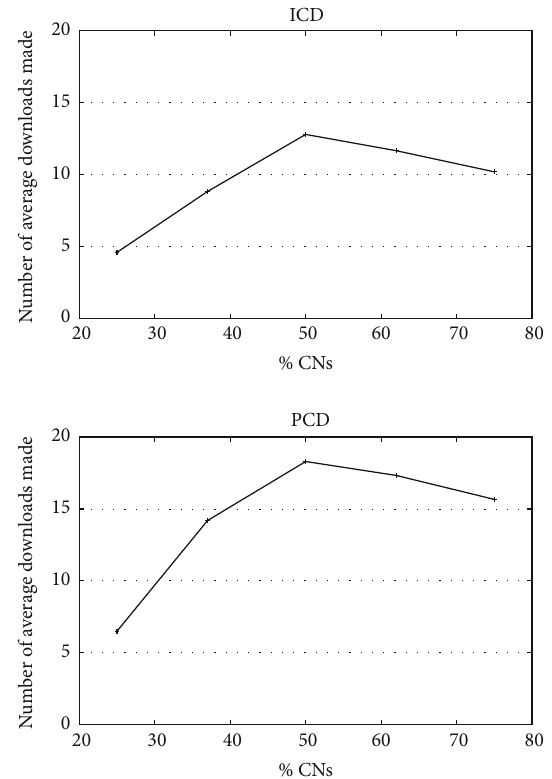
Figure 12: Average number of downloads performed in ICD and PCD against different ratios of CNs within the